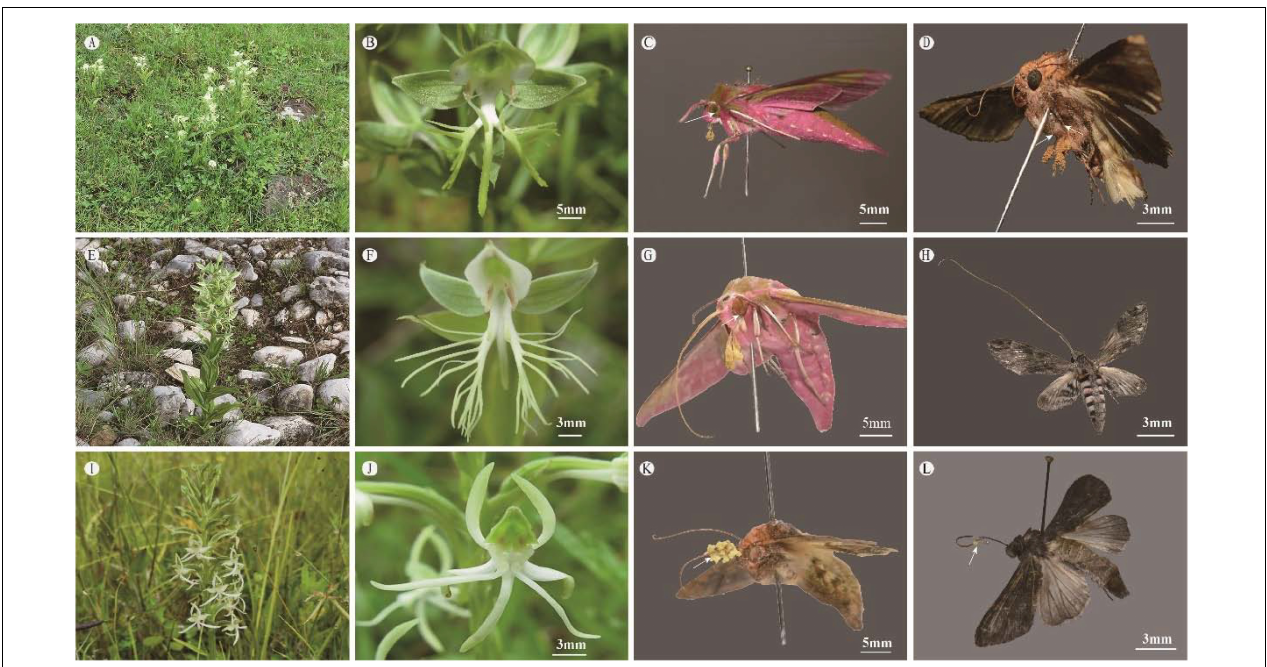
FIGURE 2 | The floral morphology and pollinators of three Habenaria species at Yulong Snow Mountain, Lijiang, southwestern Yunnan, China. The habitat (A) and flowers (B) of H. limprichtii ; (C) pinned specimen of Deilephila elpenor subsp. lewisii with pollinaria of H. limprichtii deposited on its eyes; (D) pinned specimen of Trichoplusia intermixta with pollinaria of H. limprichtii deposited on the lateral-ventral side of the thorax and the femora of middle and hind-legs; the habitat (E) and flowers (F) of H. davidii ; (G) pinned specimen of Deilephila elpenor subsp. lewisii with pollinaria of H. davidii deposited on its eyes; (H) pinned specimen of Agrius convolvuli with long proboscis and without carrying any pollinaria of H. davidii ; the habitat (I) and flowers (J) of H. delavayi ; (K) pinned specimen of Trichoplusia intermixta with pollinaria of H. delavayi deposited on proboscis; (L) pinned specimen of Apamea sp. with one pollinarium of H. delavayi deposited on the proboscis.